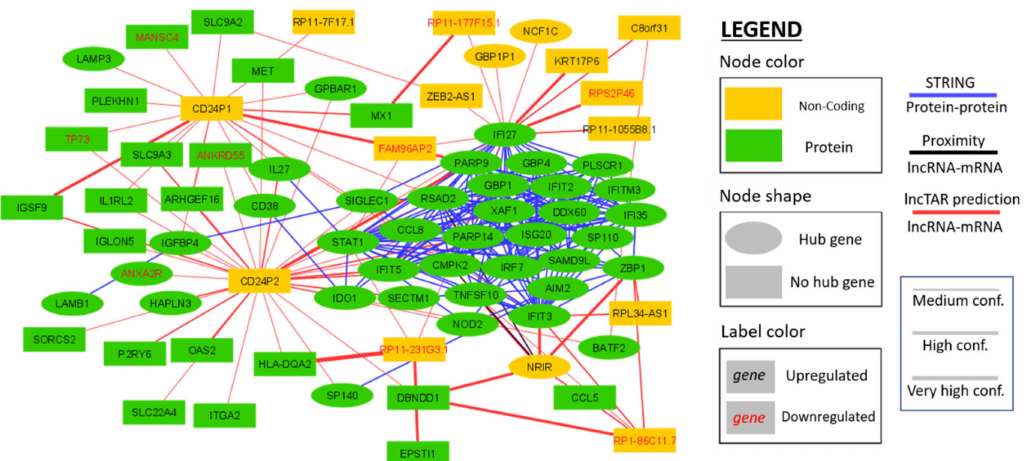
Figure 5. Network displaying the predicted interactions between the genes of the brown module that are di ff erentially expressed upon HIV-1 infection. Three interaction types are depicted: (1) protein–protein interactions determined with the STRING webtool [24]; (2) Poly-A + ncRNA–mRNA interactions predicted by LncTAR based on the binding free energy between the mRNA and the lncRNA sequences [25]; and (3) ncRNA–mRNA interactions based on genomic co-localization